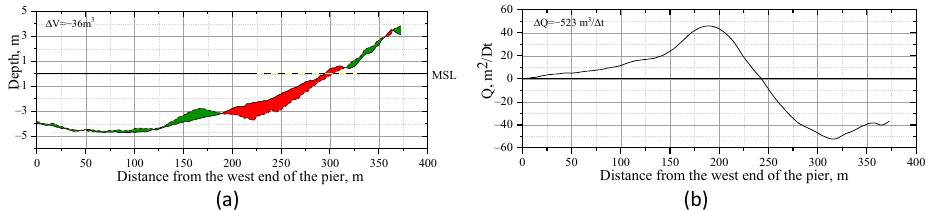
Figure 10. ( a ) Cross-shore profile changes (green-sand accumulation, red-sand loss) and ( b ) sediment transport rate Q, over the period 2016 to 2017.